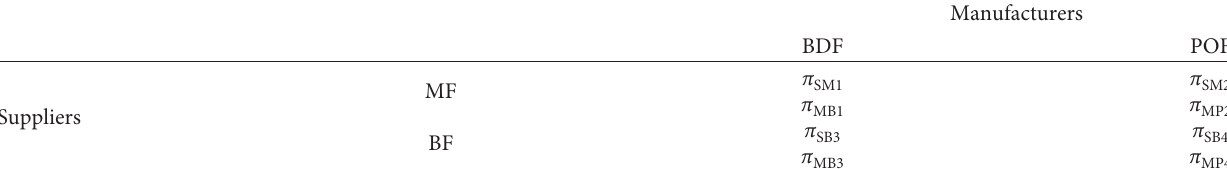
Table 2: Payoff matrix.